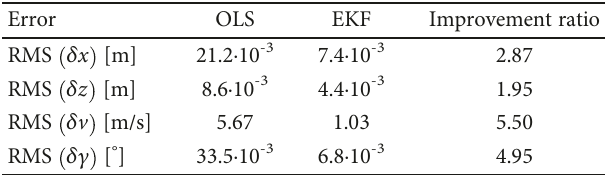
Figure 13: Error of estimation of vertical position of ICP-89.